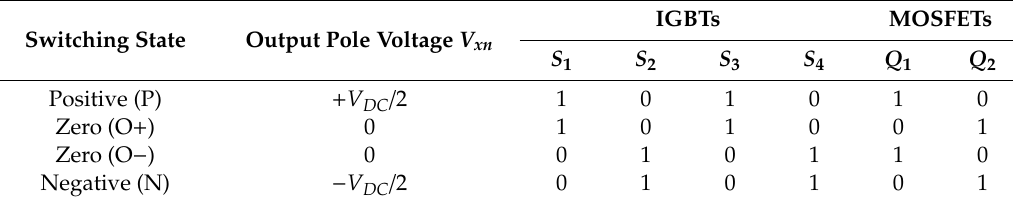
Table 1. Switching states and output pole voltage in accordance with on-o ff state of each switch in the HANPC topology (1: on, 0: o ff